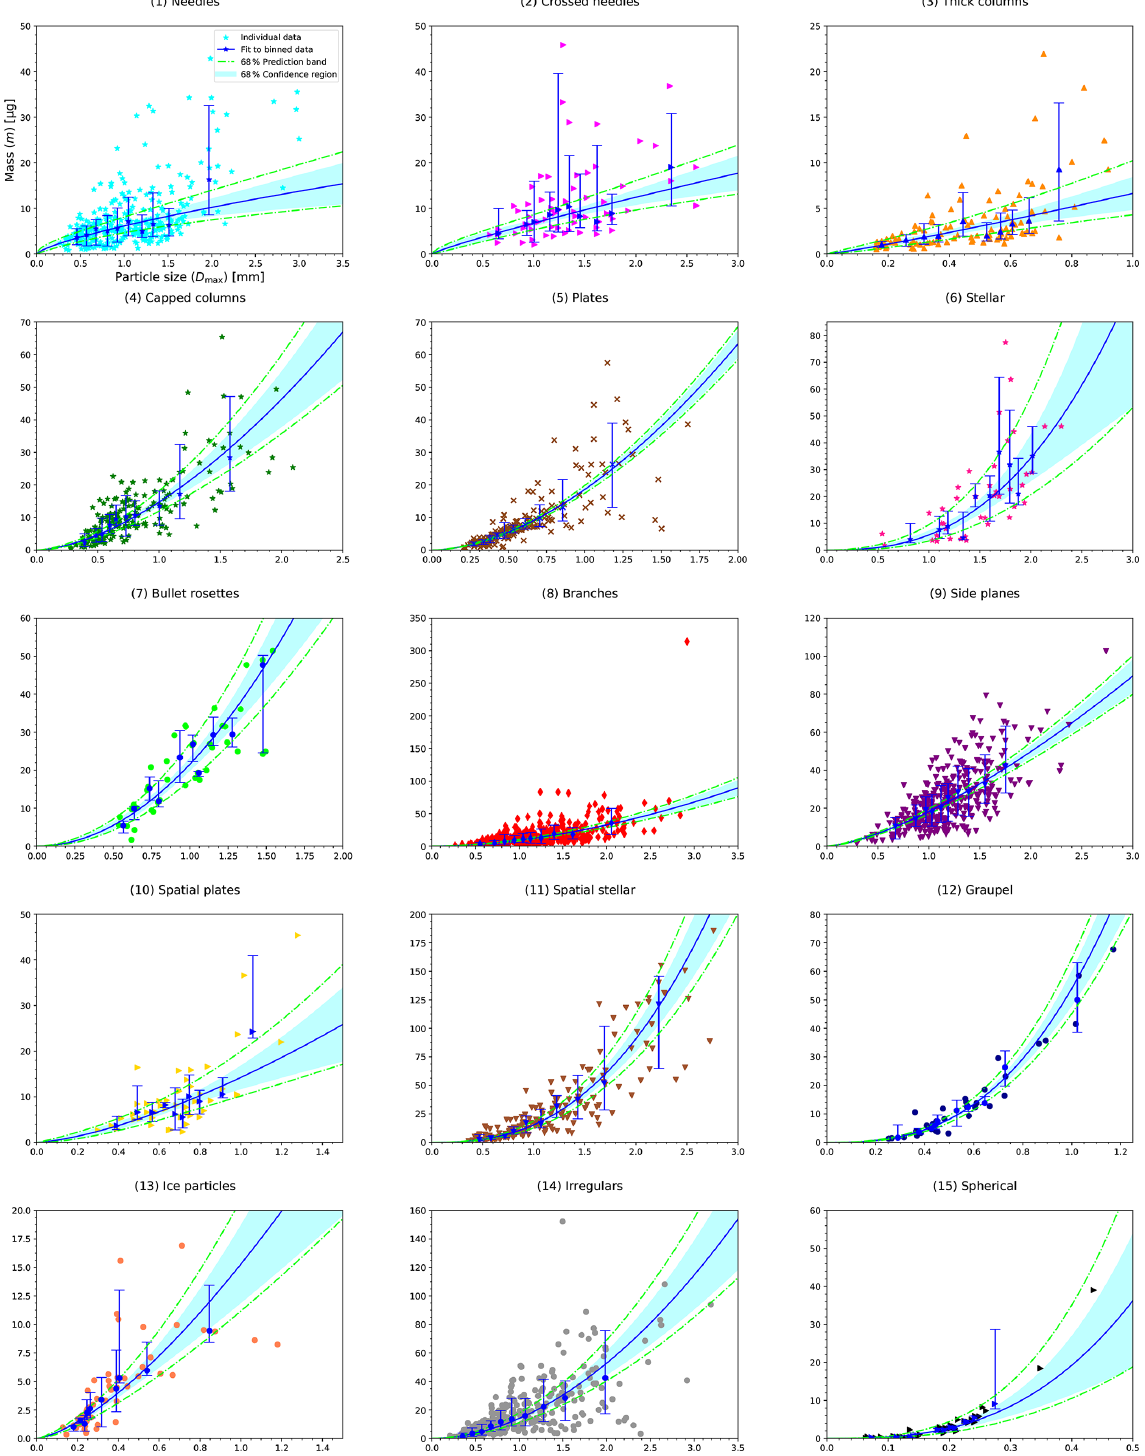
Figure A1. Mass vs. particle size ( m vs. D max ) relationships given by Eq. (8) for all the shape groups are shown. Individual data (coloured symbols) and binned data (blue symbols with error bars) are displayed. Median values in the respective bins represent the binned data. The total length of the error bars represents the spread in mass data, which is given by the difference between the 16th and 84th percentiles. The relationships fitted to binned data are shown. The 68% prediction band and the 68% confidence region for the fits are also shown. The same data are shown in Table